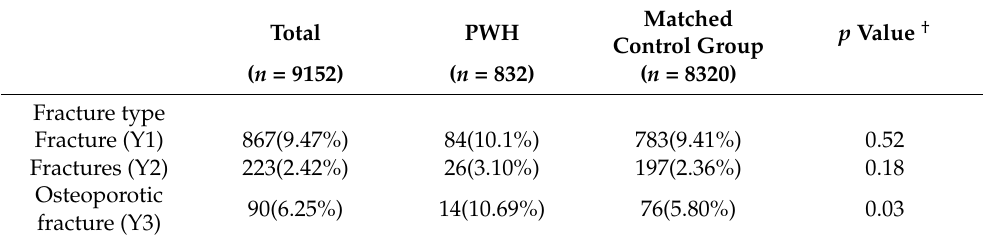
Table 2. Incidence of all-site fractures, repeated fractures and osteoporotic fractures among PWH and the matched control